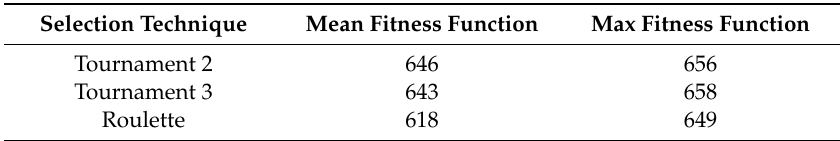
Table 1. Selection technique analysis. Mean and maximum fitness function values in Scenario 1 for Tournament 2, Tournament 3, and